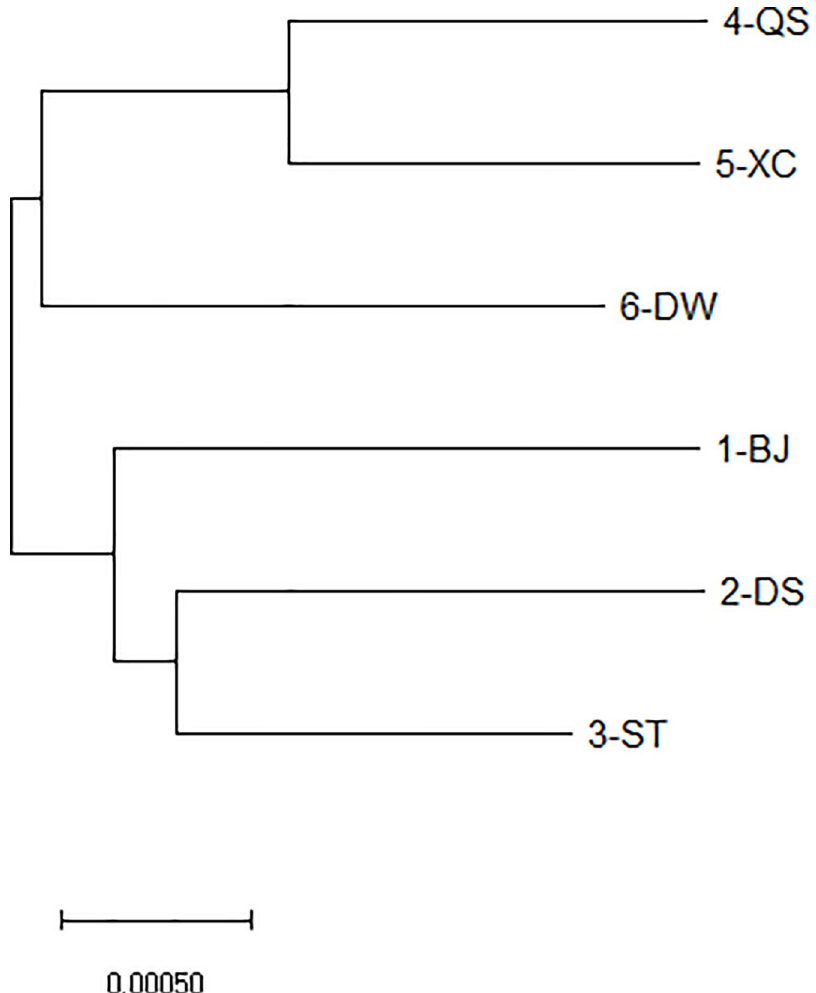
Fig 3. The dendrogram of the six Spartina alterniflora populations in Guangxi based on genetic distance. correlated with soil salinities (43.85% explained of the total variable, P -value = 0.001) and the average annual mean temperature (44.99% explained of the total variable, P -value = 0.003)